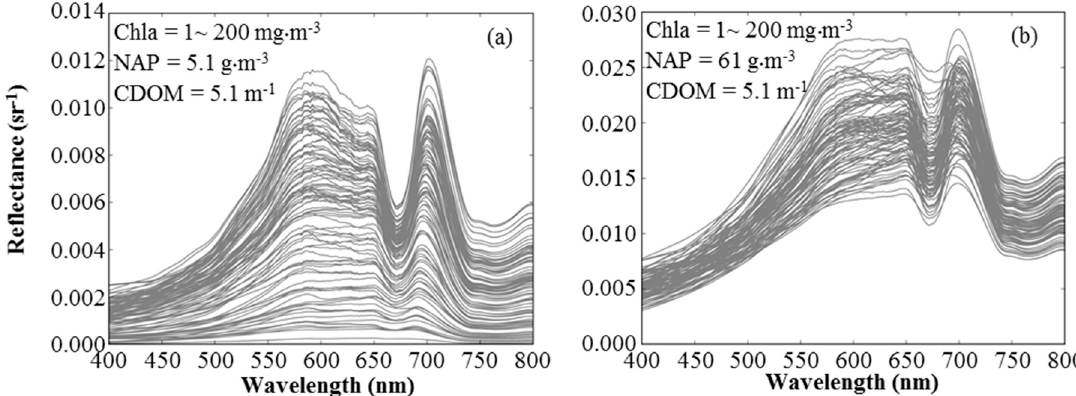
Figure 4. Examples of simulated reflectance spectra. Both panels show simulated reflectance spectra for chlorophyll- a (Chla) in ranges of 1~200 mg·m − 3 and colored dissolved organic matter (CDOM) of